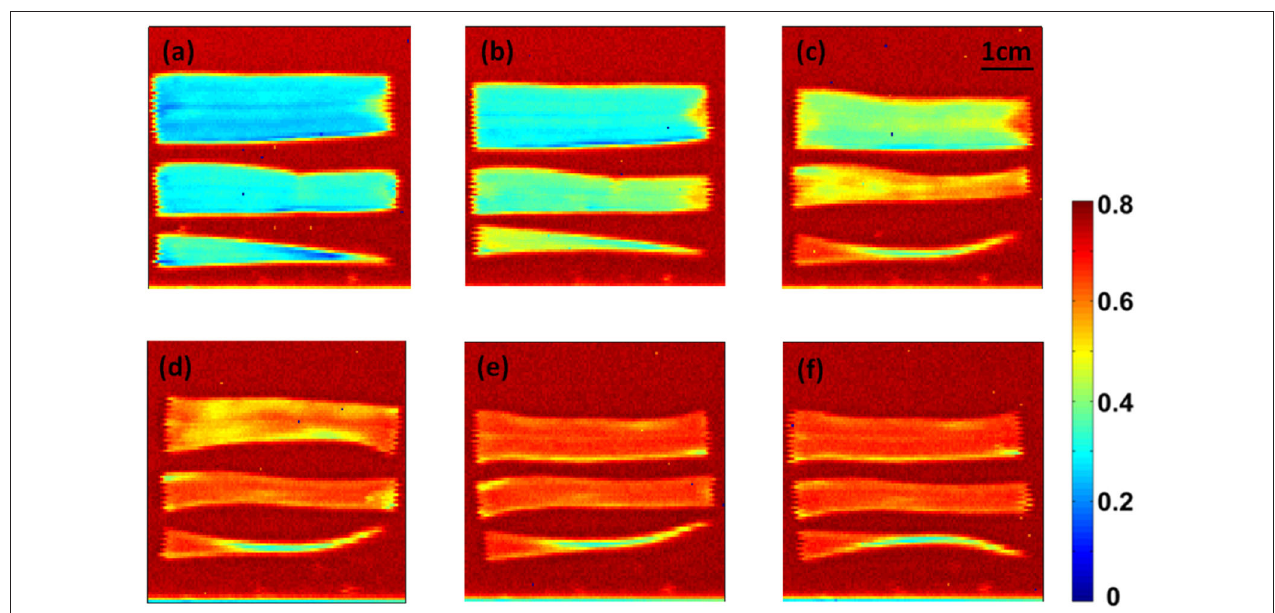
FIGURE 2 | Time-domain imaging of wheat leaf in six different time points with an interval of 2h: (a) 13:00, (b) 15:00, (c) 17:00, (d) 19:00, (e) 21:00 and (f) 1:00.